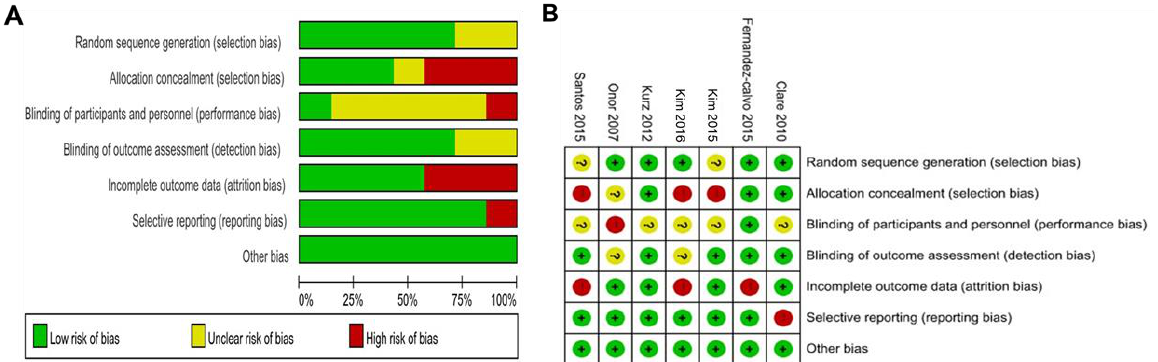
Figure 2. Risk of bias assessment across randomized controlled trials. Risk of bias graph ( A ) and summary ( B ).